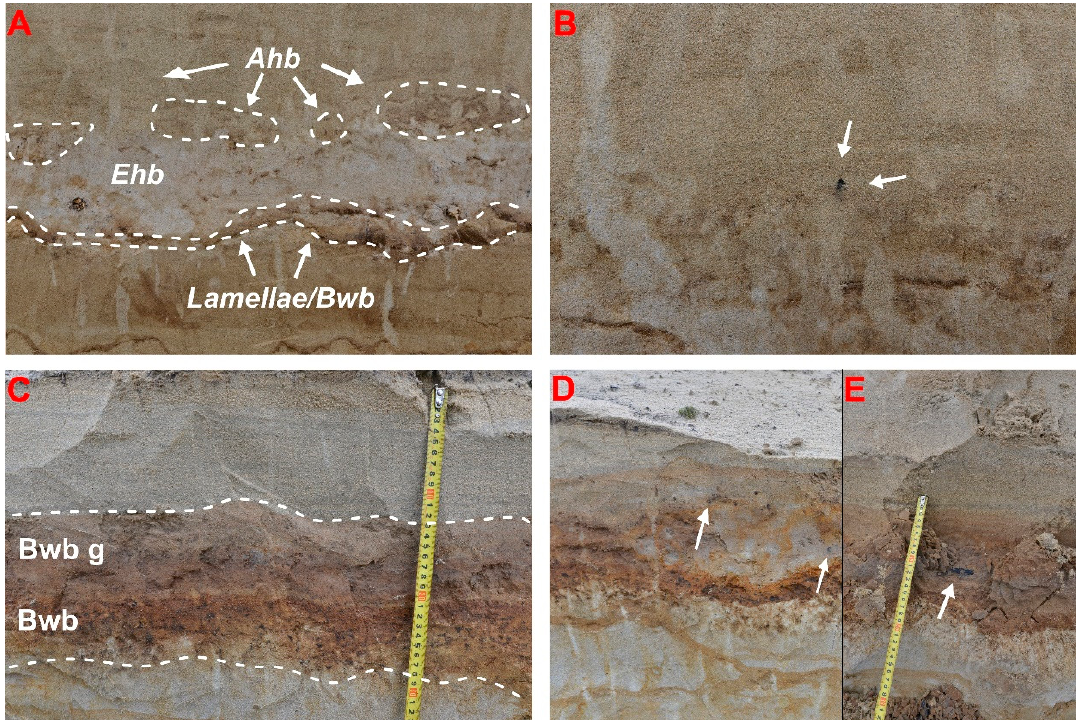
Figure 5 . Morphological features of studied paleosols: ( A ) separated morhons of Ahb, Eb, and thick lamellae possibly developed over Bwb horizon of Ussel-like paleosol in section 1; ( B ) stratified Bwb horizon of Finow-like paleosol in section 2; ( C ) large charcoal in Ahb horizon, section 1; ( D,E ) charcoals in Bwb horizon, section 2.